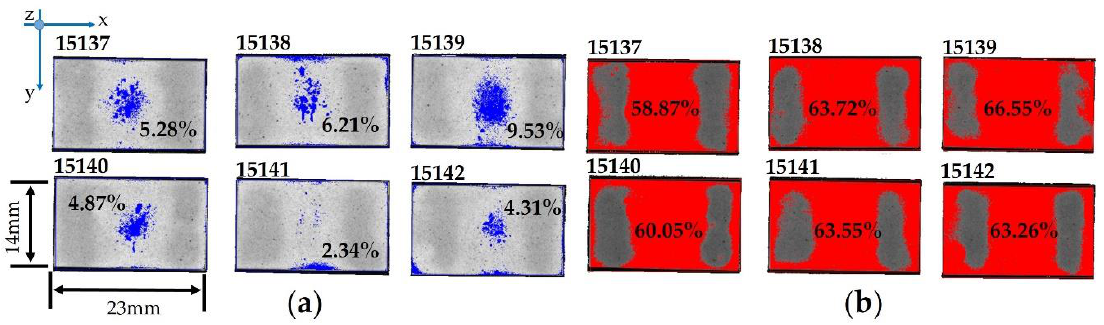
Figure 16. Detection of non-compliant areas [%] for lot #4: ( a ) blisters (blue color); ( b ) thicker epoxy resin (red color).